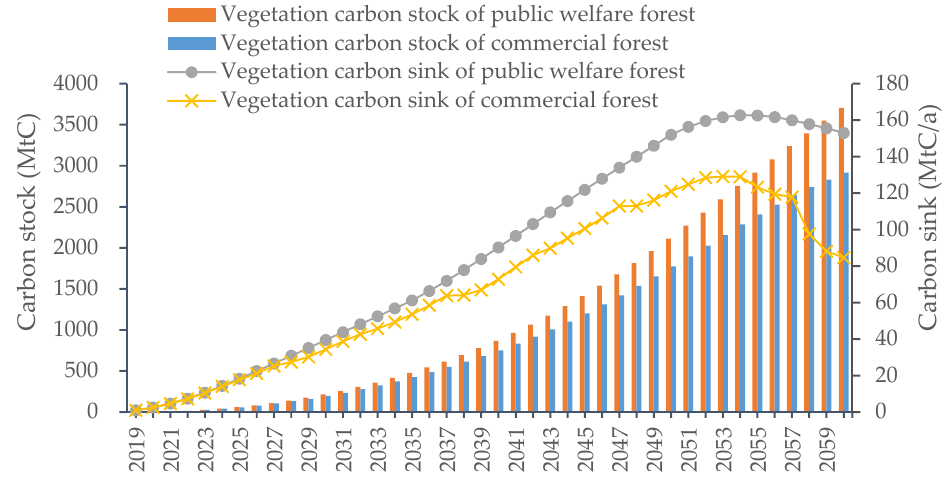
Figure 4. Vegetation carbon sink by new afforestation.